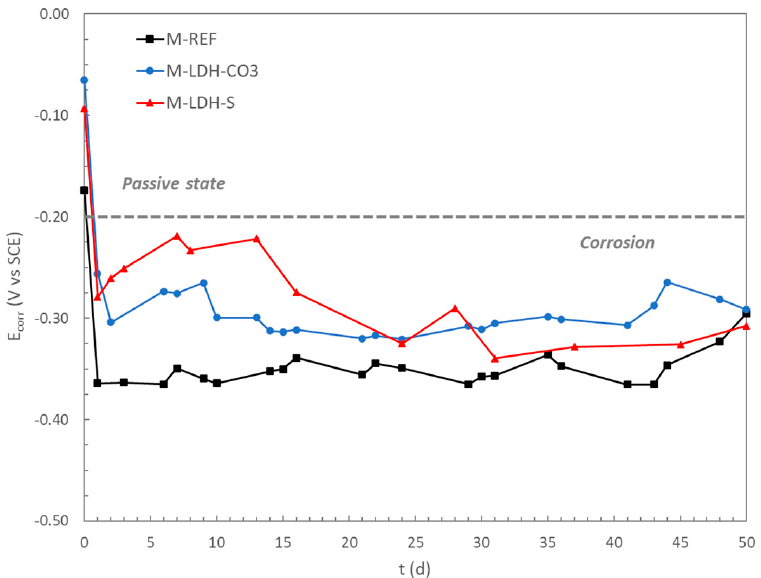
Figure 8. Evolution of the corrosion potential for the three studied reinforced mortars during the corrosion stage (exposure to chloride action).